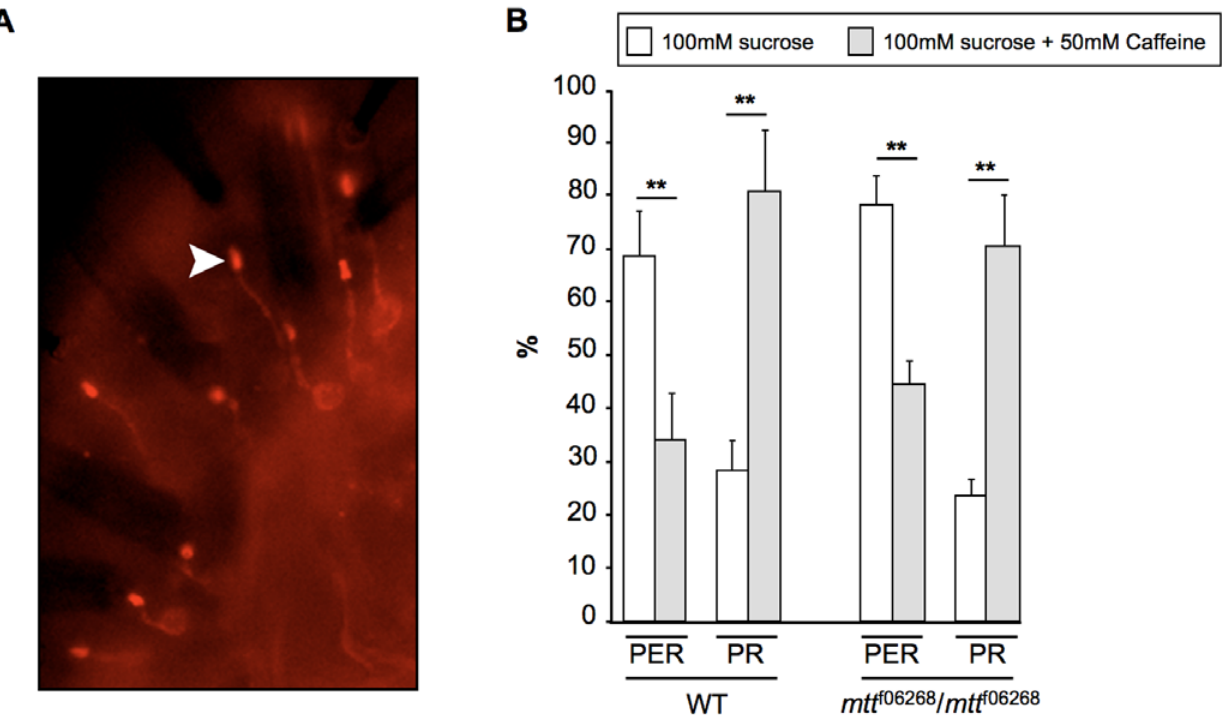
Figure 8. DmXR is localized to GRN dendrites and is dispensable for caffeine sensitivity. (A) Subcellular localization of the DmX receptor. Anti-HA immunostaining on labellum of Gr66a-GAL4/ + ;UAS-HAmtt/ + flies. HAmtt is a HA-tagged version of the DmX receptor. When DmXR is expressed in Gr66a-GRNs, it is principally targeted to the dendrite. Note the strong localization of the receptor at the tip of the dendrite (arrowhead). (B) The aversive effect of caffeine is not affected in mtt mutant flies. Behavioral analyses were performed as described in Figure 6 except that 100 mM sucrose (white) and 100 mM sucrose + 50 mM caffeine (grey) solutions were used. Histograms show the percentage of PER and PR of control (WT) and mtt mutant ( mtt f06268 /mtt f06268 ) flies. For both control and mtt mutant flies, the caffeine inhibits the sucrose-induced PER. This effect is not complete as some flies still performed a PER in the presence of caffeine. Most of these flies retract their proboscis in response to caffeine, similar to what is observed with L -canavanine. Error bars indicate SEM. Double asterisks indicate significant differences by t -test ( p ,